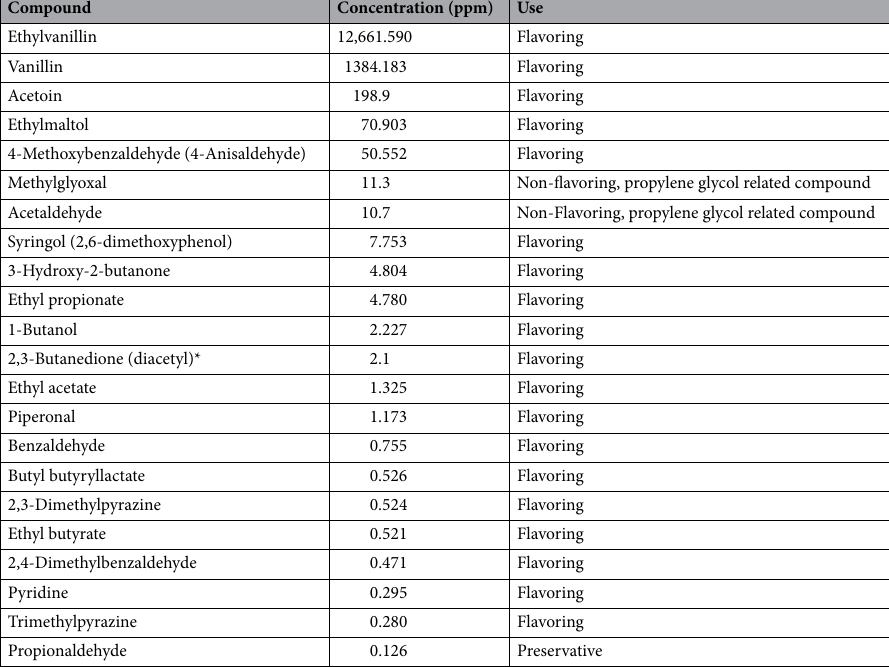
Table 1. Compounds Identified in e-cig smoke solution. *The concentration of diacetyl in our in vitro study was based on the initial Mass-Spec analysis of e-cig smoke solution (89 ppm) in 2016. Due to high volatility, diacetyl in solution quickly decreased since the e-cig solution was first generated.